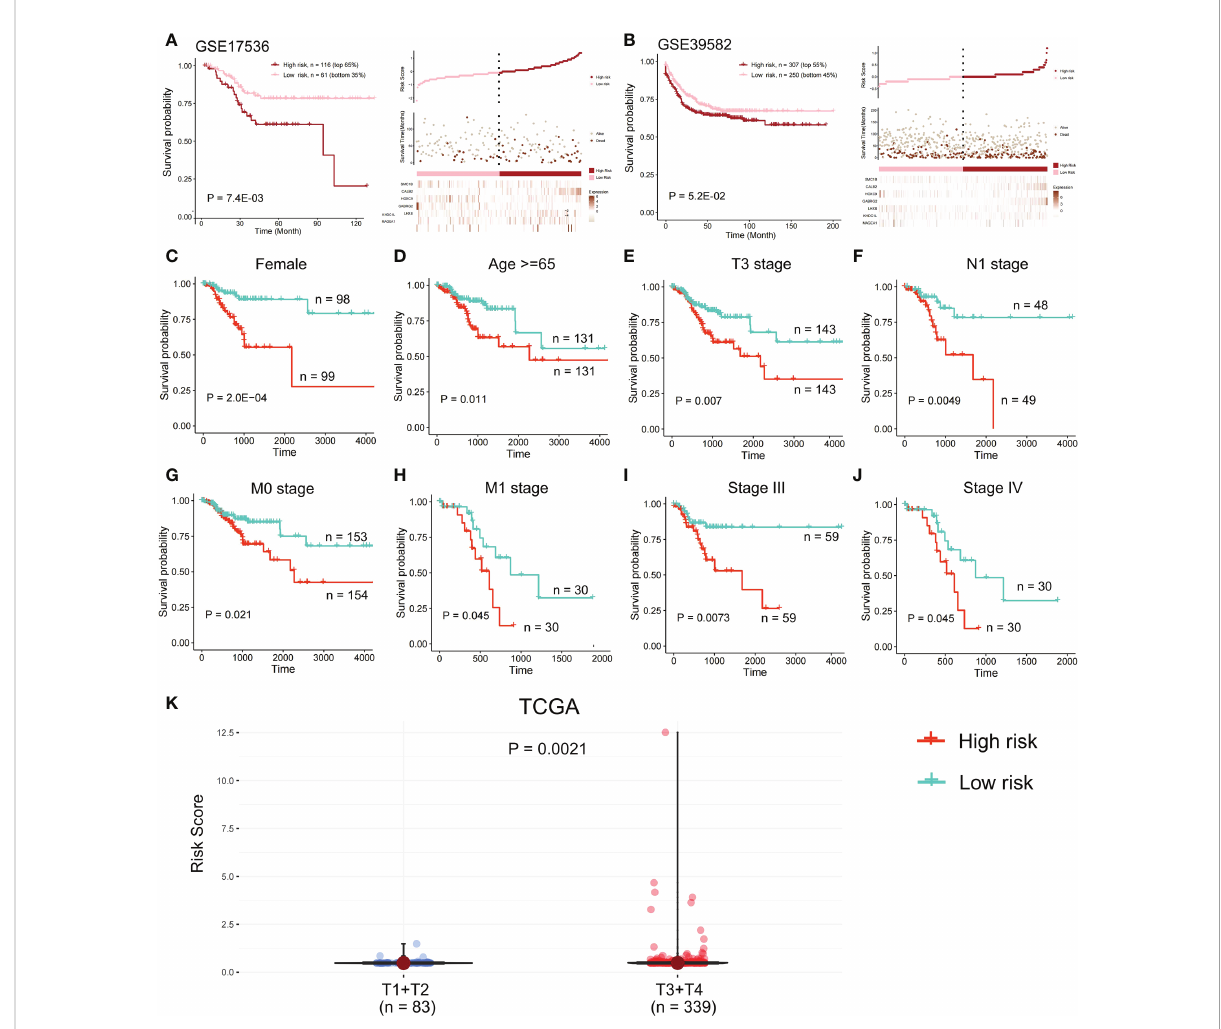
FIGURE 6 Survival analysis in the validation set. OS difference and the survival and risk score distribution among the two risk samples were evaluated using a log-rank test in (A) validation set GSE17536 and (B) validation set GSE39582. Samples of high risk group in GSE17536: 116. Samples of low risk group in GSE17536: 61. Samples of high risk group in GSE39582: 307. Samples of low risk group in GSE39582: 250. (C-J) In TCGA cohort, a log- rank test was employed to evaluate OS difference among two risk samples of females, older patients, T3 stage, N1 stage, M subgroups (M0 and M1), and pathological stage (Stages III and IV). (K) Risk score of T1+T2 group and T3+T4 group was